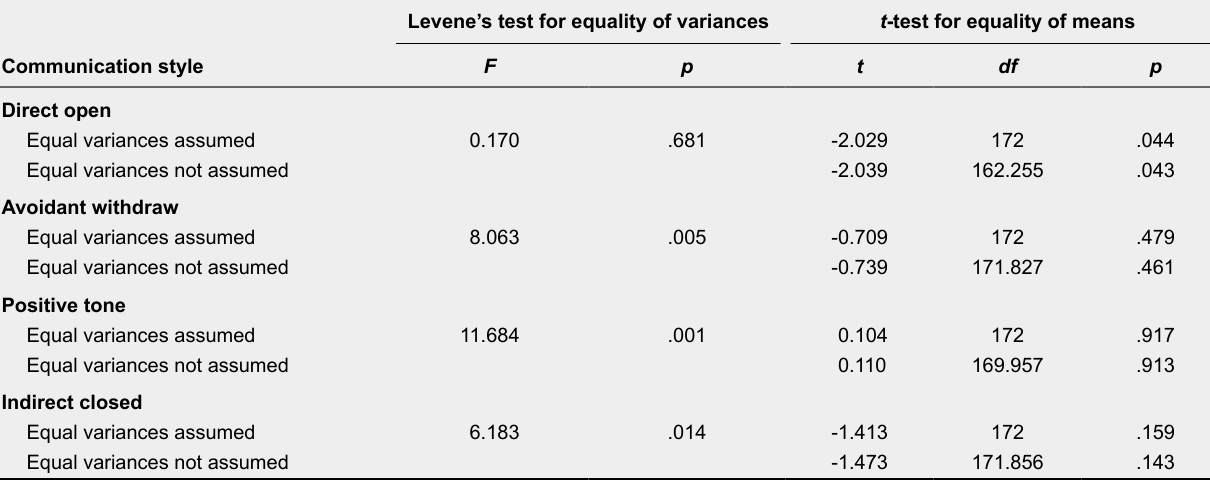
Independent Samples t-Test: Comparison of Participant Sex on Breakup